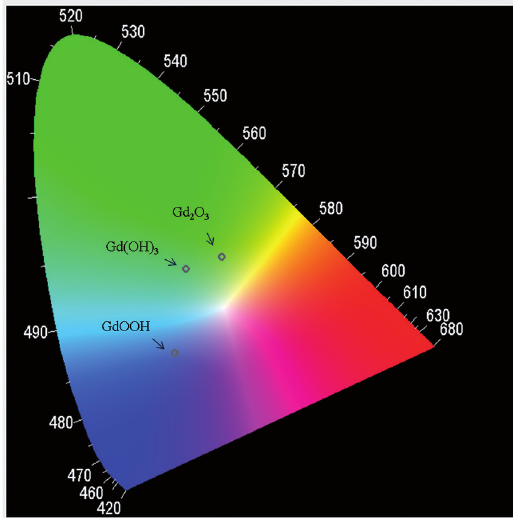
Figure 5: CIE chromaticity diagram for the